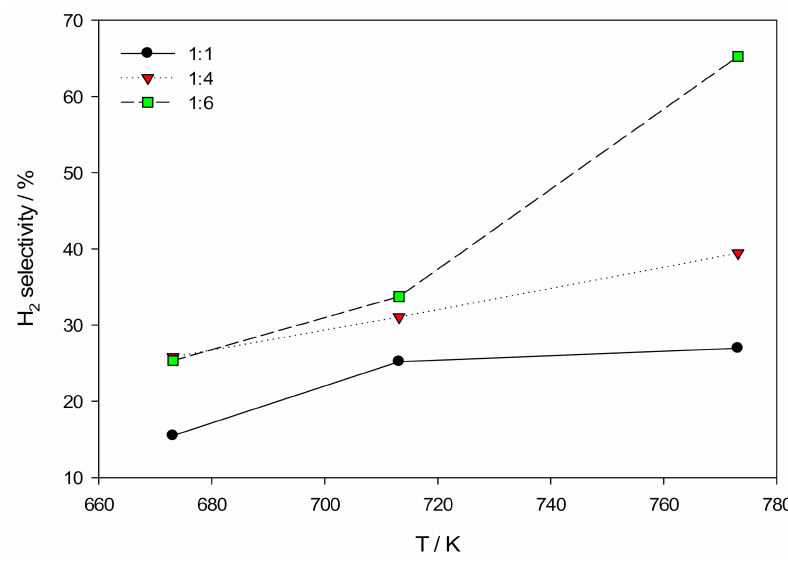
Figure 5. Hydrogen selectivity of SCWG from guava fruit waste at different B:W mass ratio.